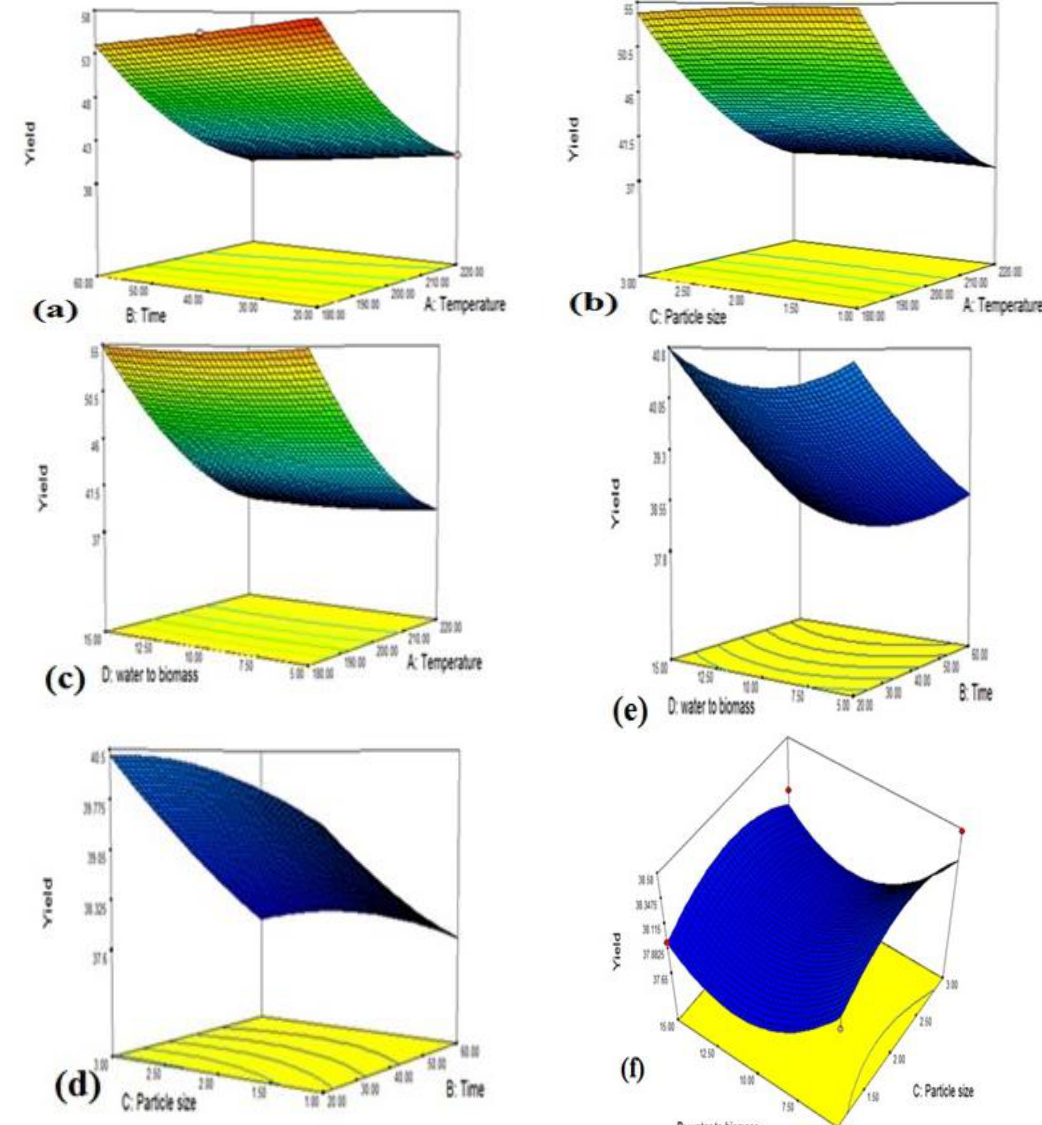
Figure 3. Three-dimensional graphs of ( a ) the reaction temperature and time, ( b ) the reaction temperature and particle size, ( c ) the reaction temperature and biomass to water ratio, ( d ) the reaction time and particle size, ( e ) the reaction time and biomass to water ratio, and ( f ) the particle size and biomass to water